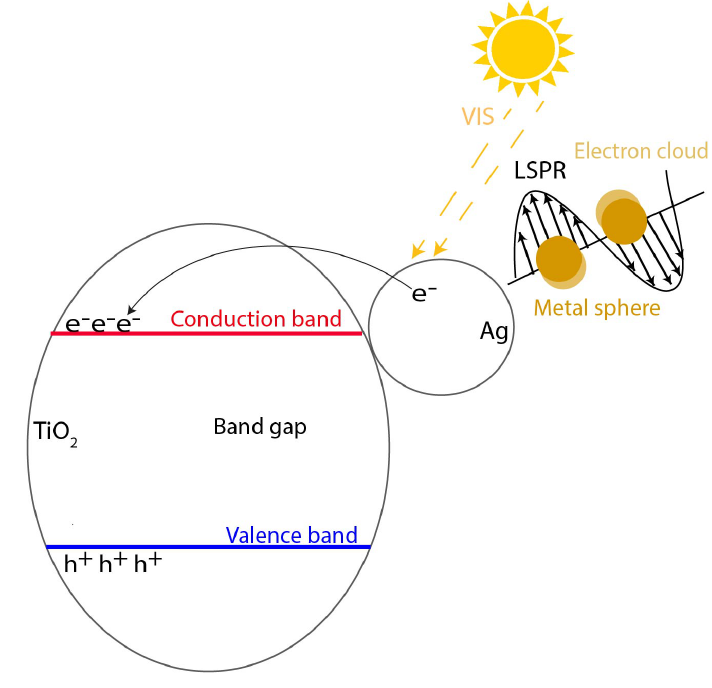
Figure 3. Schematic representation of the surface plasmon resonance (SPR) effect of silver doped TiO 2 . Doping with transition metals can also positively influence the photoactivity of TiO 2